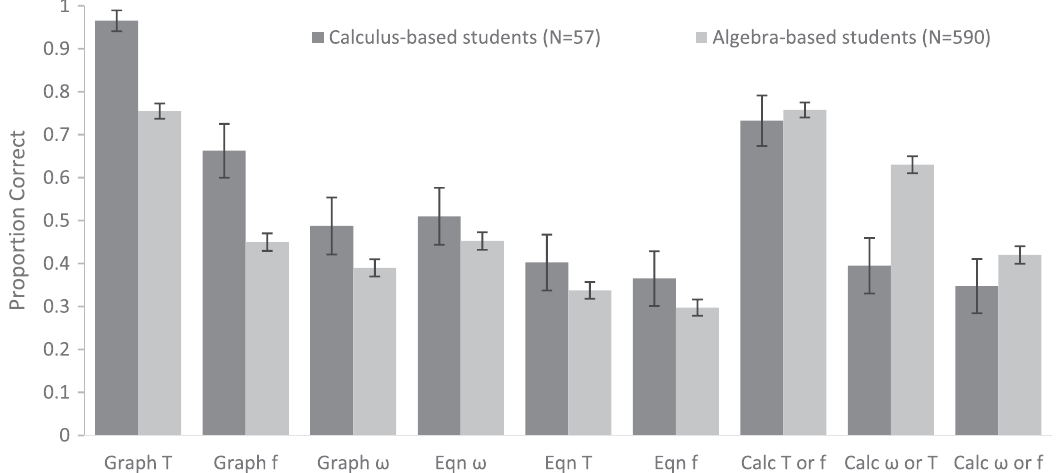
FIG. 2. The proportion of correct responses plotted for each of the nine skill categories by each population of students. Not all students saw questions from each of the nine skills.